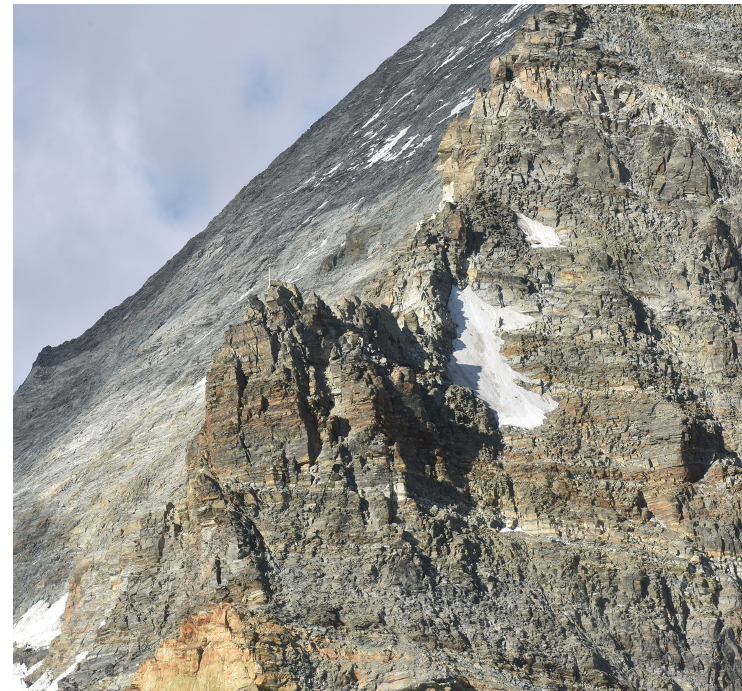
Figure C2. North of the detachment zone (light gray-colored rock) a small ice field is visible delimiting the strongly fractured topography close to the ridge from the northern